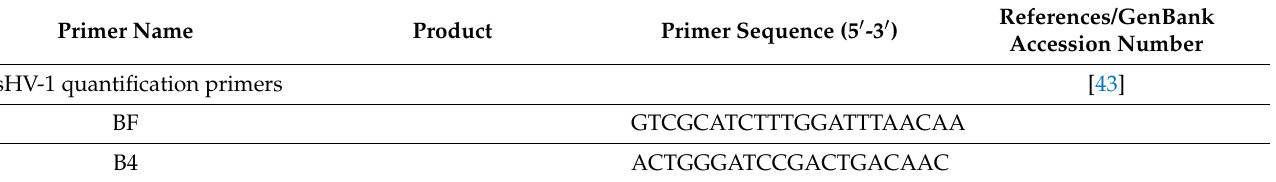
Table 1. PCR primers used in this